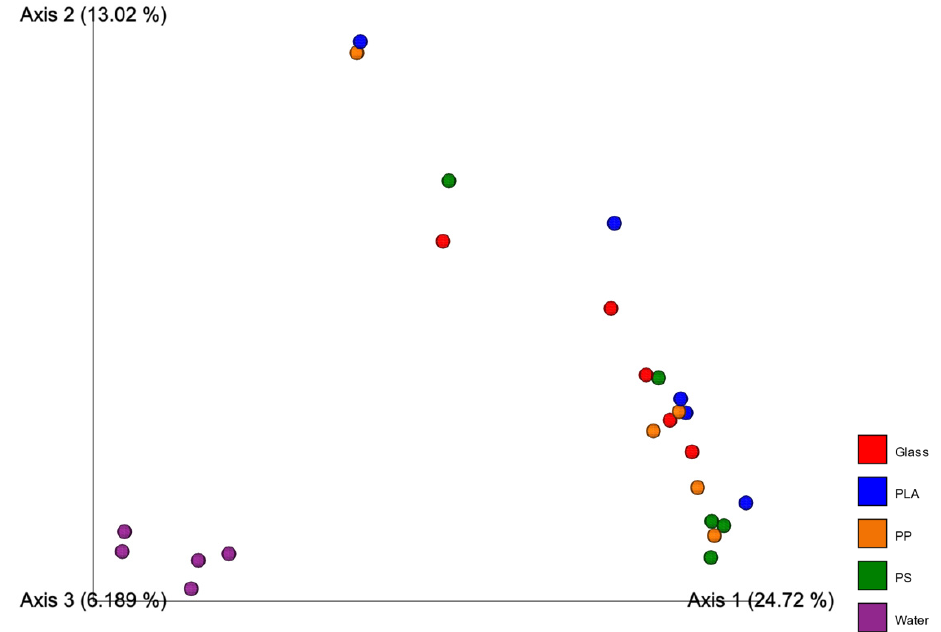
Figure 4. PCoA plots showing the dissimilarity of samples grouped by material they were extracted from. Beta diversity measures show the unweighted unifrac distance.